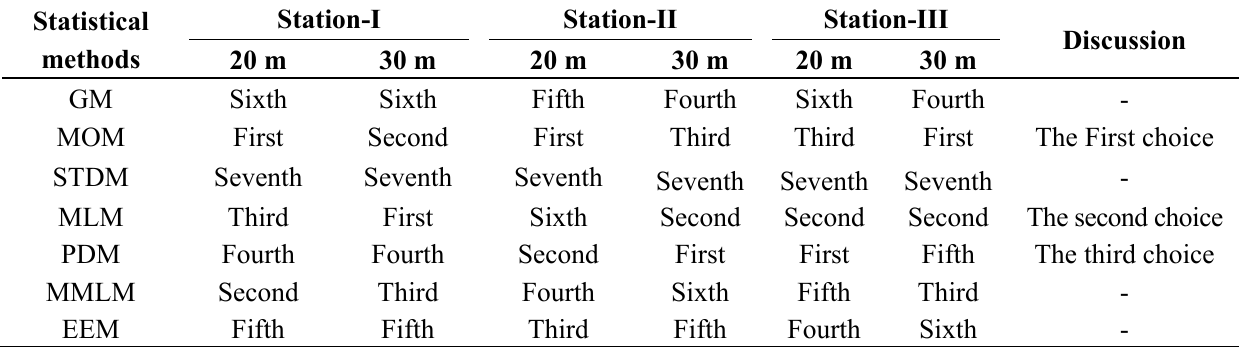
Table 10. Ranking of the methods by statistical test